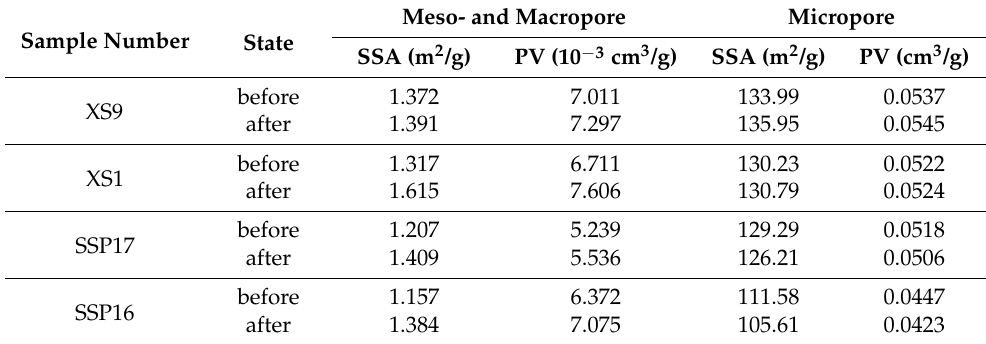
Table 4. Summary of PV and SSA of micro- and macro/mesopore in samples pre- and post-SFE. Sample